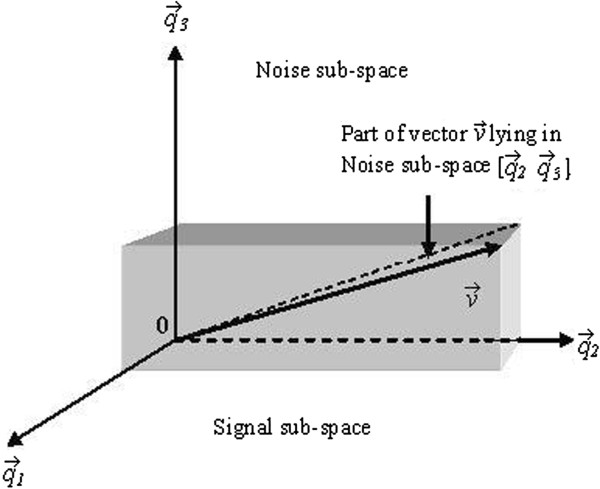
Projection of signal vectorv→on noise sub-space in a three -dimensional vector space.